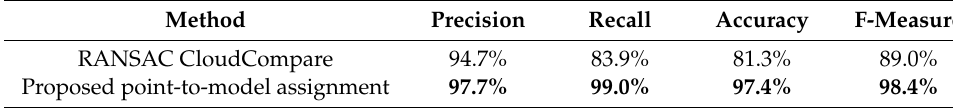
Table 2. Summary of the quality of point-to-model assignment using our method and